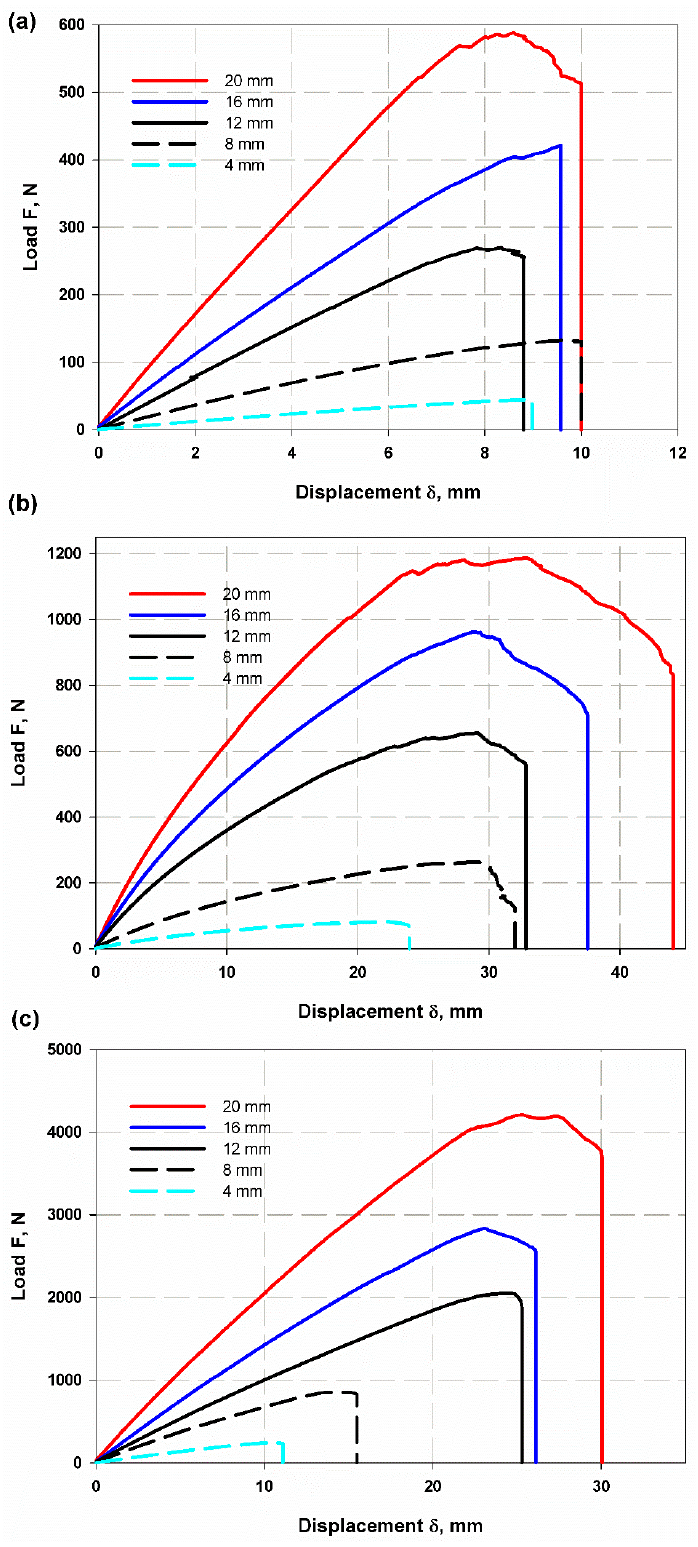
Figure 12. Load and displacement curve in EWF ( a ) CFRP, ( b ) GFRP-W and ( c ) GFRP-R.